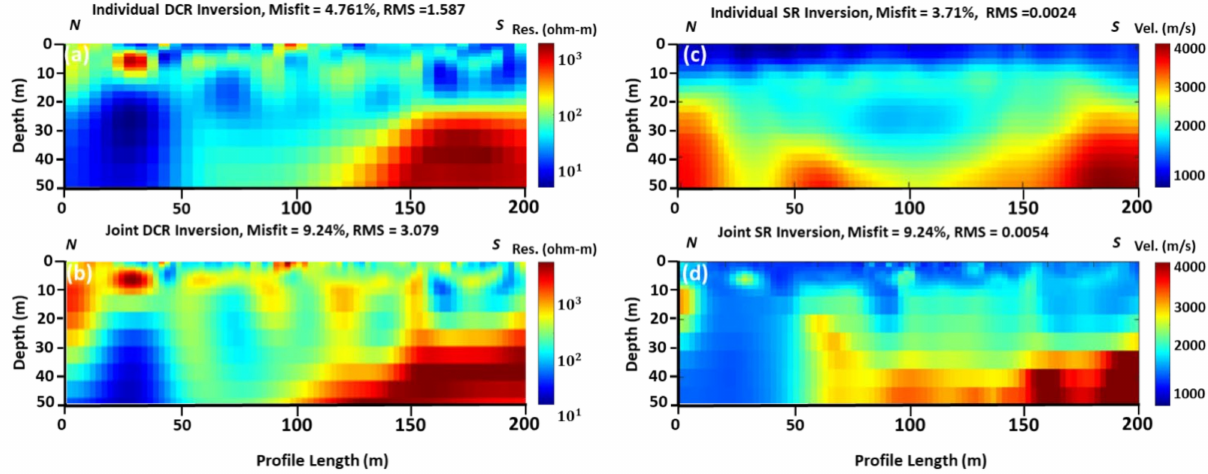
Figure 4. DCR2 and SR2 (see Figure 1b for location) inversion using local optimization method: ( a ) individual inverted resistivity model; ( b ) joint inverted resistivity model; ( c ) individual inverted ve- locity model; and ( d ) joint inverted velocity model. All geophysical models are vertically exaggerated by